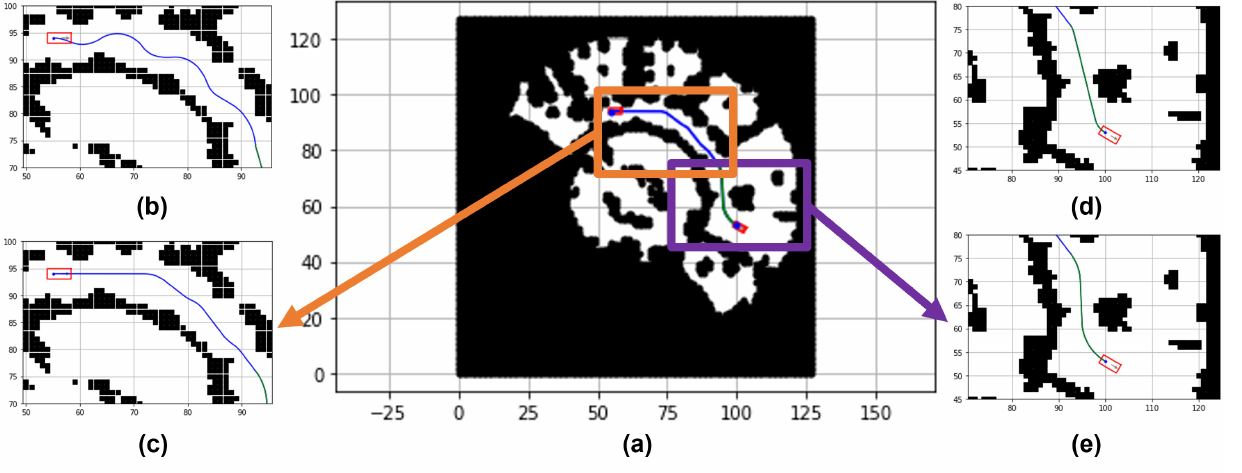
Figure 10. Improved hybrid A-star in a benchmark map ost003d . ( a ) Improved hybrid A-star. ( b ) Before tunings. ( c ) After tunings. ( d ) Original RS path. ( e ) Improved RS